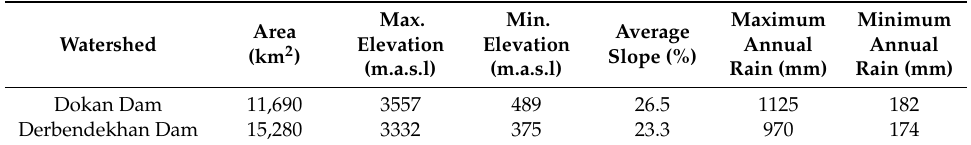
Figure 1. Topographic map of the watershed areas of the Dokan and Derbendekhan Dams and their locations in Iraq. Table 1. Properties of the Dokan and Derbendekhan